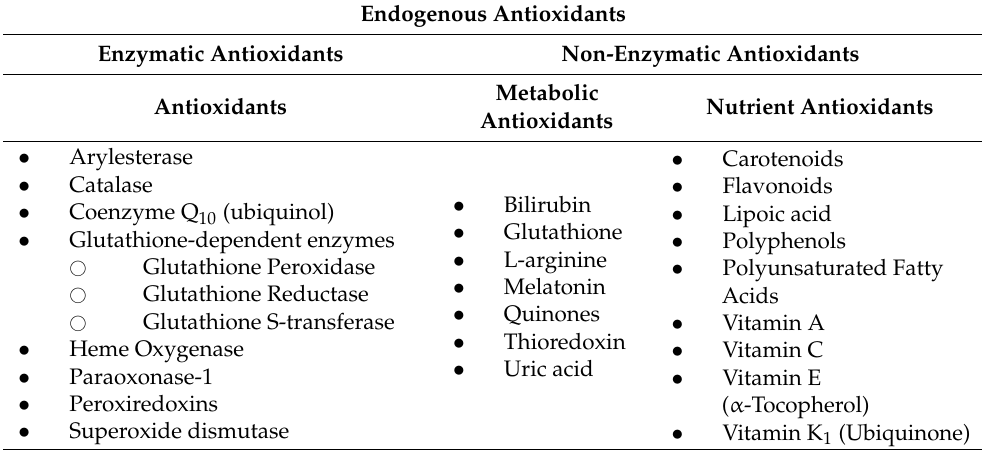
Table 1. Table classifying the different forms of endogenous antioxidants with appropriate